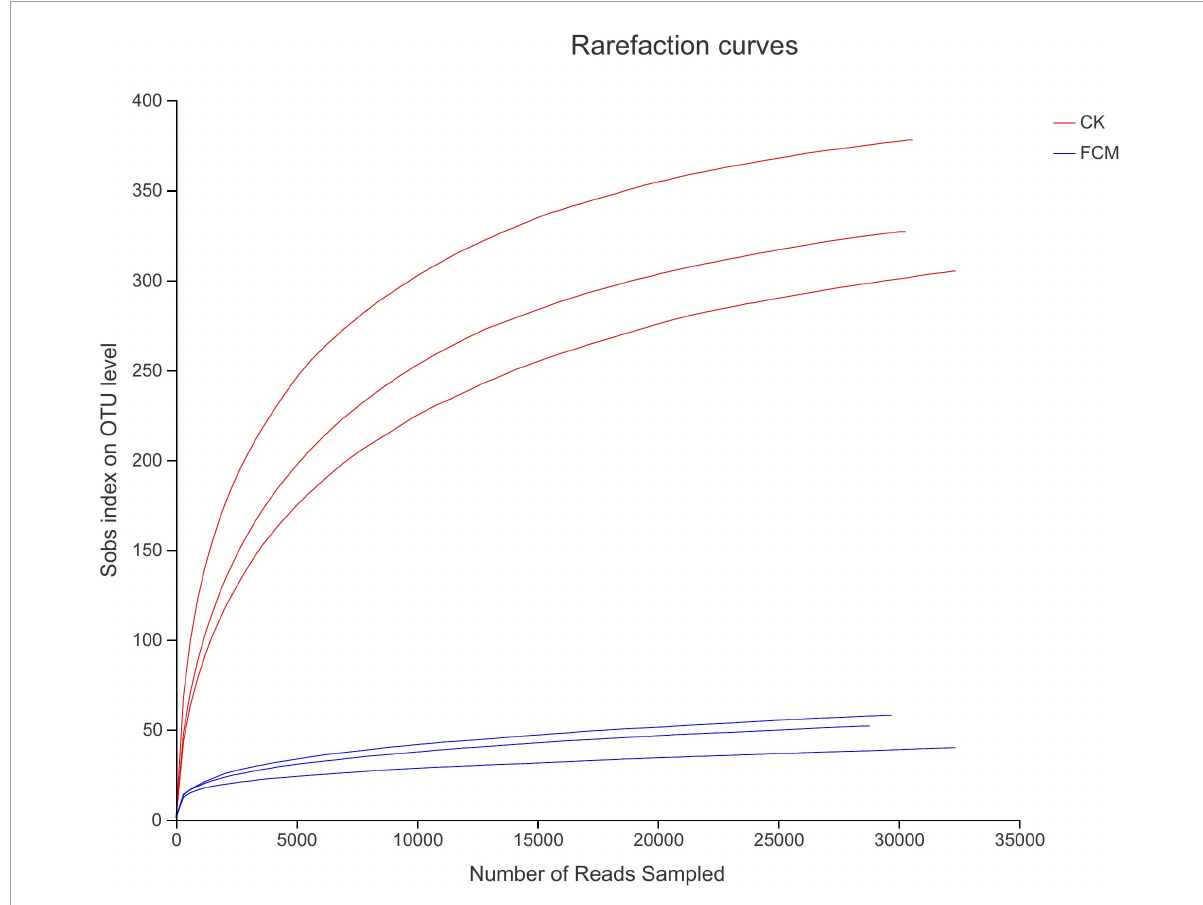
FIGURE4 Rarefaction curves based on OUT level. Rarefaction curves based on observed species value. The rarefaction curve was plotted where the X-axis represents the number of clones (sequences) and the Y-axis represents the number of OUT [CK: cottonseed meal (CM); fermented cottonseed meal (FCM):